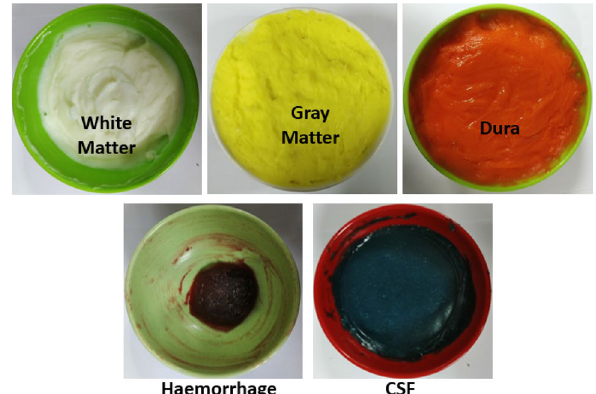
Figure 3. Fabricated components of the head phantom.